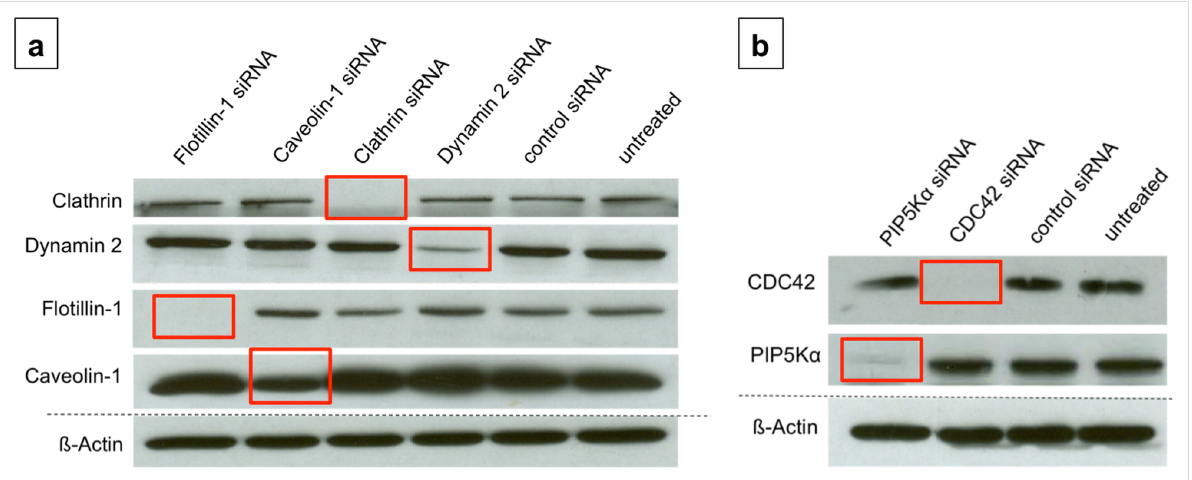
Figure 3: Representative X-ray films with knockdown efficiency of target proteins (red labels), ß-Actin serves as the protein loading control for compa- rable protein contents in the horizontal lines, control siRNA = siRNA with nonsense sequence, untreated = control cells without siRNA treatment; (a) Knockdown efficiency of Flotillin-1, Caveolin-1, Clathrin and Dynamin-2; (b) Knockdown efficiency of CDC42 and PIP5K α .